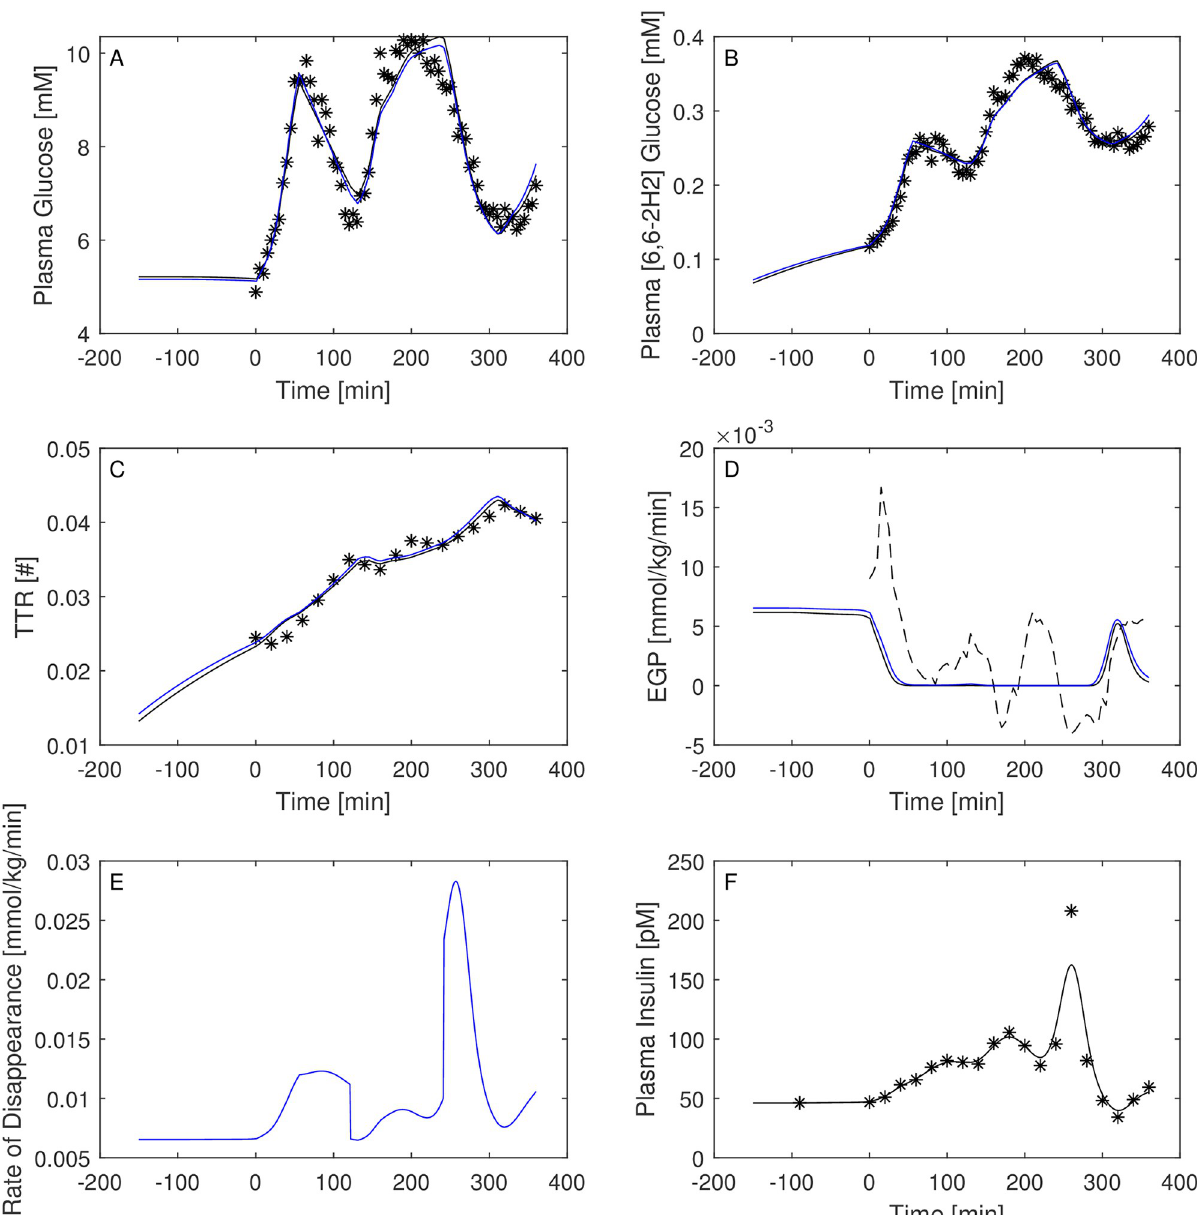
Fig 4. Predictions for Subject 2. Observed (asterisks) and predicted (line) variables over time (NGT subject). EGP: Endogenous Glucose Production; TTR: Tracer to Tracee ratio. Plasma glucose concentration (Panel A); Plasma [6, 6-2H2]glucose (Panel B); TTR (Panel C); EGP (Panel D), dashed line is the predicted EGP with the Steele model; Rate of disappearance (panel E); Plasma Insulin concentrations (Panel F). All the observed points refer to data measured on day 2. Plasma glucose concentrations (panel A) are derived from the glucose intra-venous infusion to match plasma glucose observations from the OGTTs of day 1. Black lines in panels A, B, C, D and E are model predictions from WLS estimation procedure; blue lines derive from the estimation approach which uses autocorrelated errors. superimposed to the estimated EGP as derived by the Steele equation (dashed line). The last two panels report smoothed insulin concentrations and the estimated rate of glucose disap- pearance (given by the sum of insulin-dependent glucose uptake and by the zero-order brain uptake) for the six studied subjects under the one-compartment glucose model. While it is